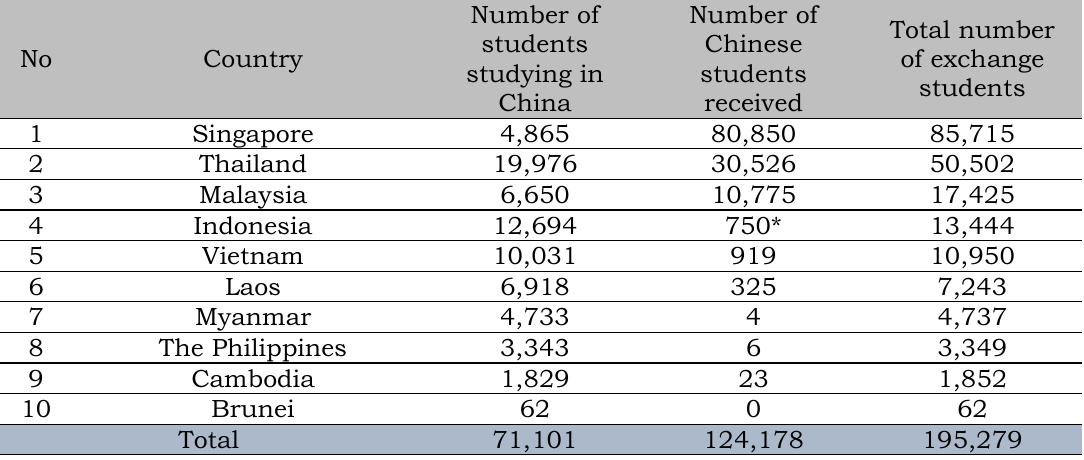
Table 2. Exchange students between China and ASEAN countries in